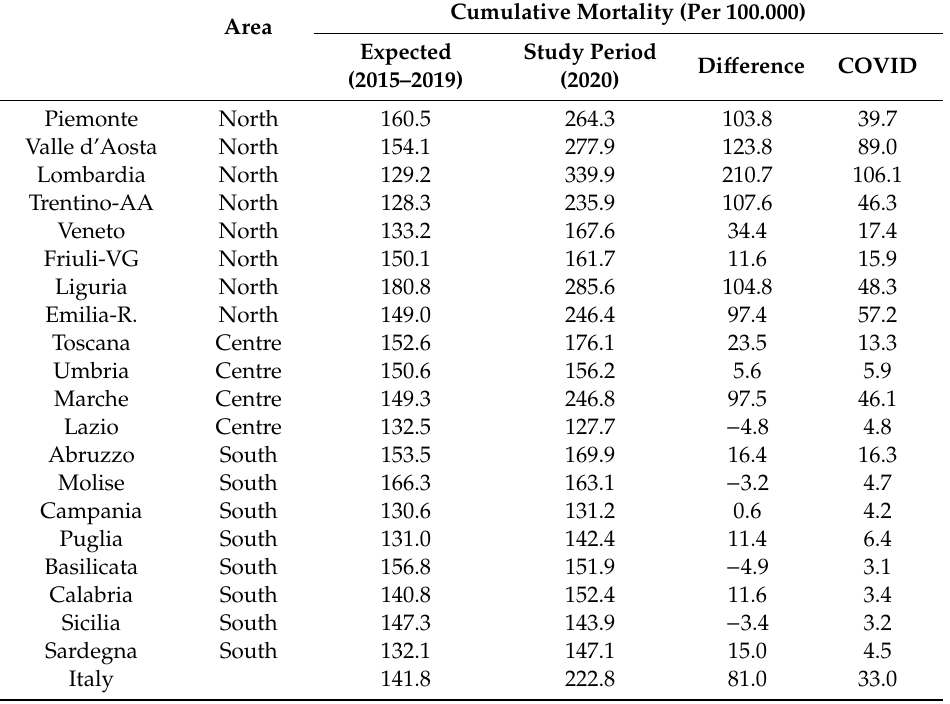
Table 3. Cumulative mortality (per 100,000) from March 1st to April 15th in the study municipalities, overall and attributed to COVID-19, by region.